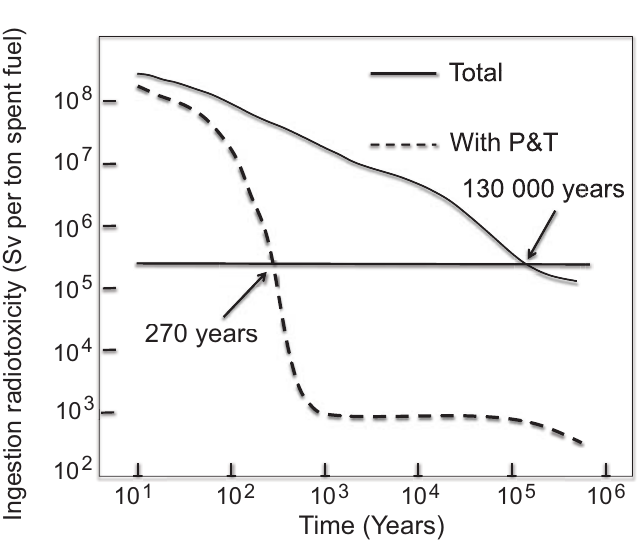
Fig. 2. – Ingestion radiotoxicity of one tonne of used nuclear fuel as a function of time, with (bro- ken line) and without (solid line) partitioning and transmutation. The horizontal line indicates the radiotoxicity of the pristine natural material used for the fabrication of the